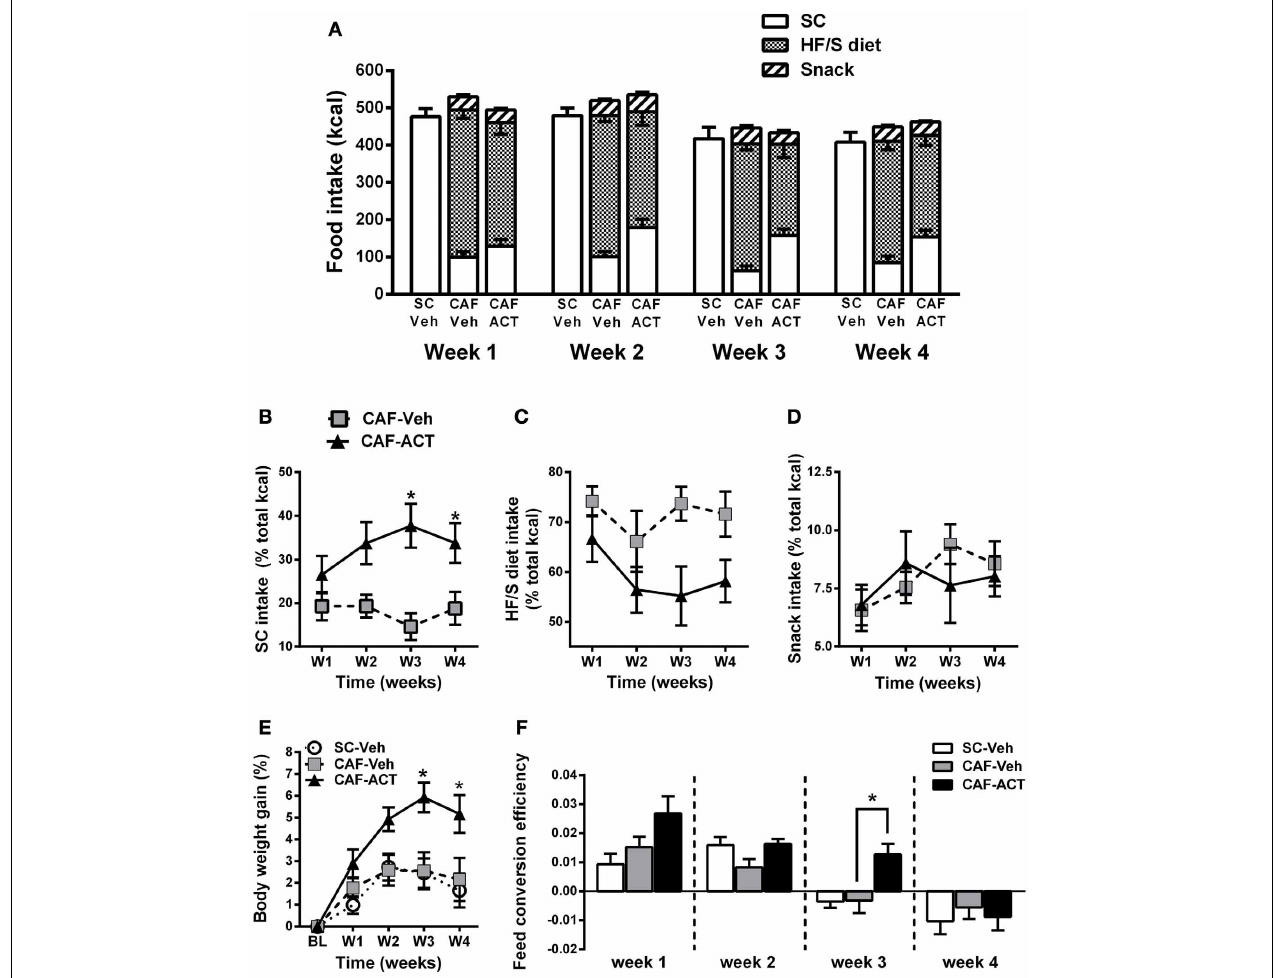
gain expressed as a percentage change from baseline (BL) weight (i.e., at start of chronic treatment). CAF-Veh and SC-Veh groups did not statistically differ from each other. ∗ p < 0 . 05 vs. CAF-Veh at the indicated time points by post-hoc test following ANOVA. (F) Weekly efficiency of conversion of total kcal intake into body weight gain. No significant differences were revealed between the SC-Veh and CAF-Veh groups. Mean ± s.e.m. ( n = 9–11) per group. ∗ p < 0 . 05 vs. CAF-Veh at the indicated time points by post-hoc test following ANOVA. Note that throughout this manuscript SC-Veh is always compared to CAF-Veh, and CAF-ACT is always compared to CAF-Veh. No comparisons between CAF-ACT and SC-Veh were made. ( SC , standard chow; CAF , cafeteria diet; Veh , vehicle; ACT , ACT-335827; HF / S , high fat/sweet).